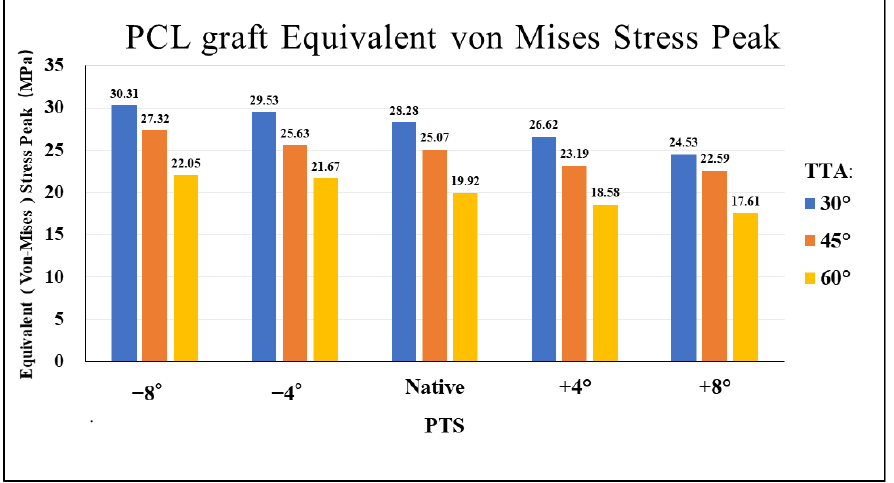
Figure 3. Bar chart of equivalents (Von Mises) stress peak diagrams for different TTAs and PTSs at the entrance of the tibial tunnel. TTA: tibial tunnel angle, PTS: posterior tibial slope.